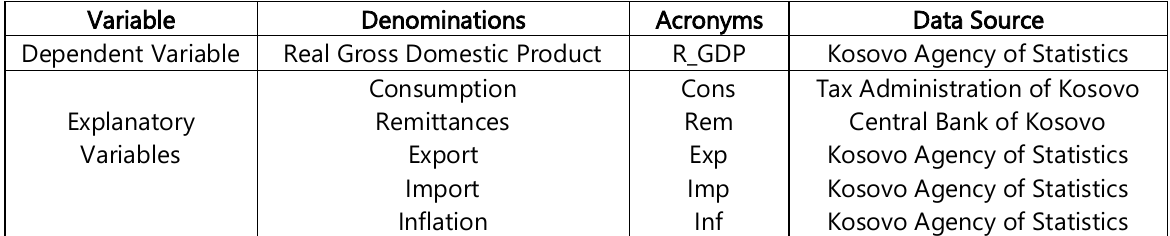
Table 1: Variable Descriptions and Data Source (Source: Authors‘ selection)